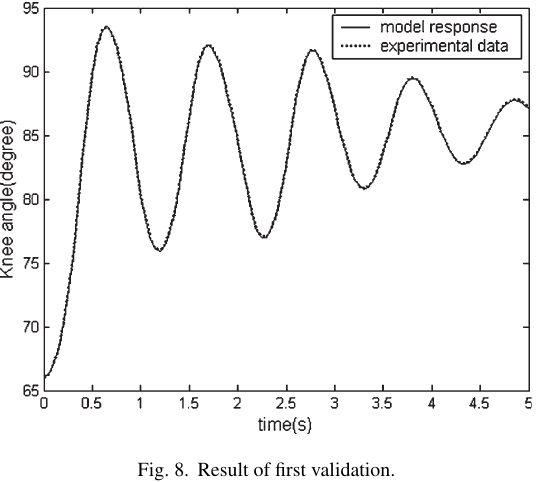
Fig. 8. Result of first